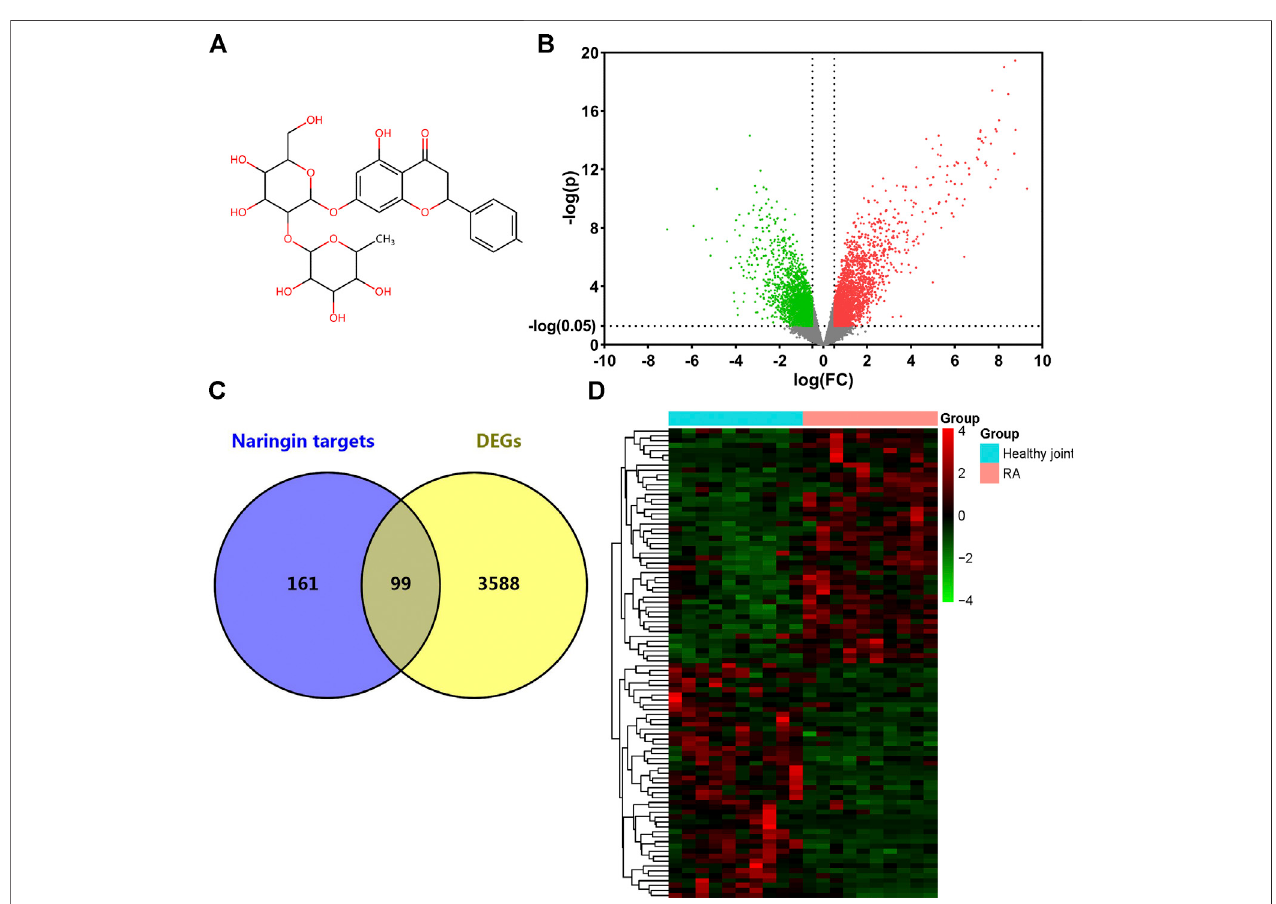
FIGURE 2 | Target genes of naringin and DEGs in GSE55235. (A) Chemical structure of naringin; (B) DEGs in GSE55235 (upregulated genes were marked in red and downregulated genes were marked in green). (C) Venn diagram of naringin target genes and DEGs. (D) Clustered heat map of overlapped genes.